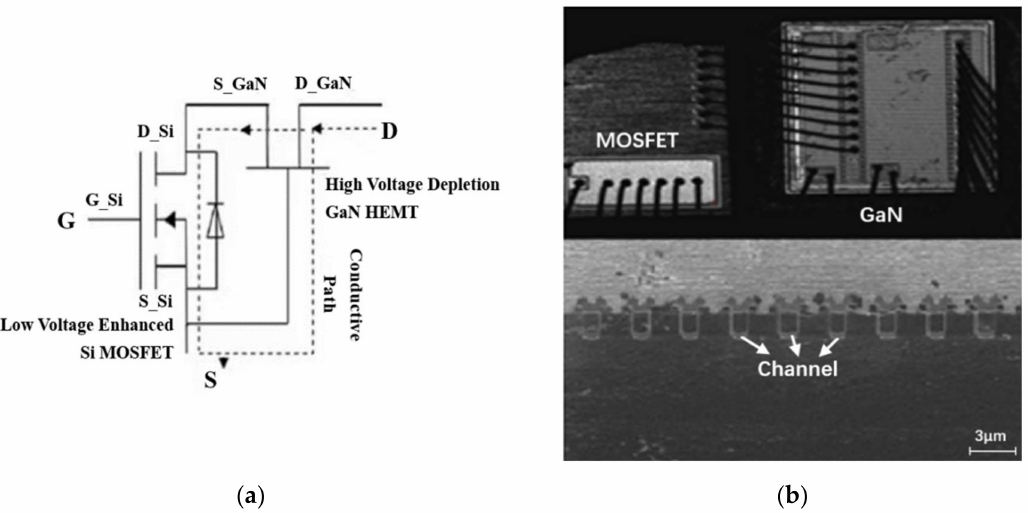
Figure 7. Schematic diagram of ( a ) the circuit structure of the GaN HEMT based on the cascode structure and ( b ) the internal MOSFET